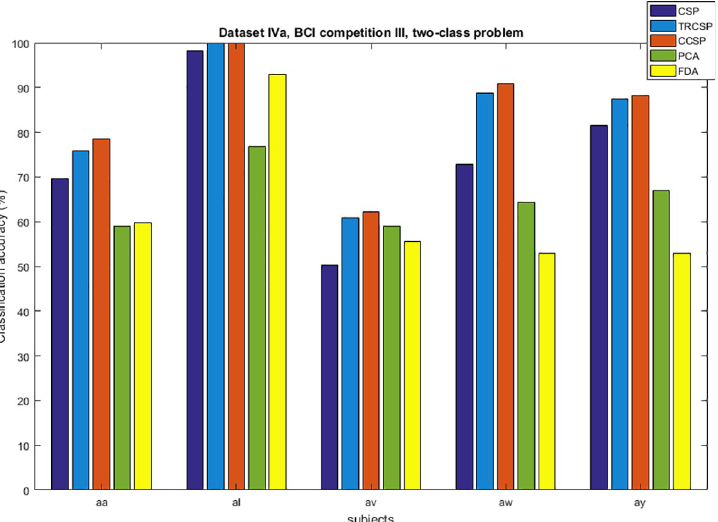
Fig 4. Comparison between classification accuracy of methods for two-class problem in dataset IVa, BCI competition III.